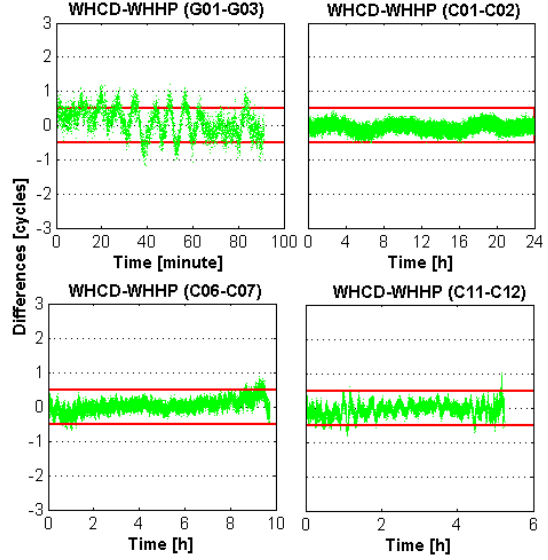
Figure 4. EWL-II time series of the GPS and BDS satellites for baseline WHCD-WHHP. The red line indicates the threshold of rounding. Green dots indicate the values of EWL-II combination.